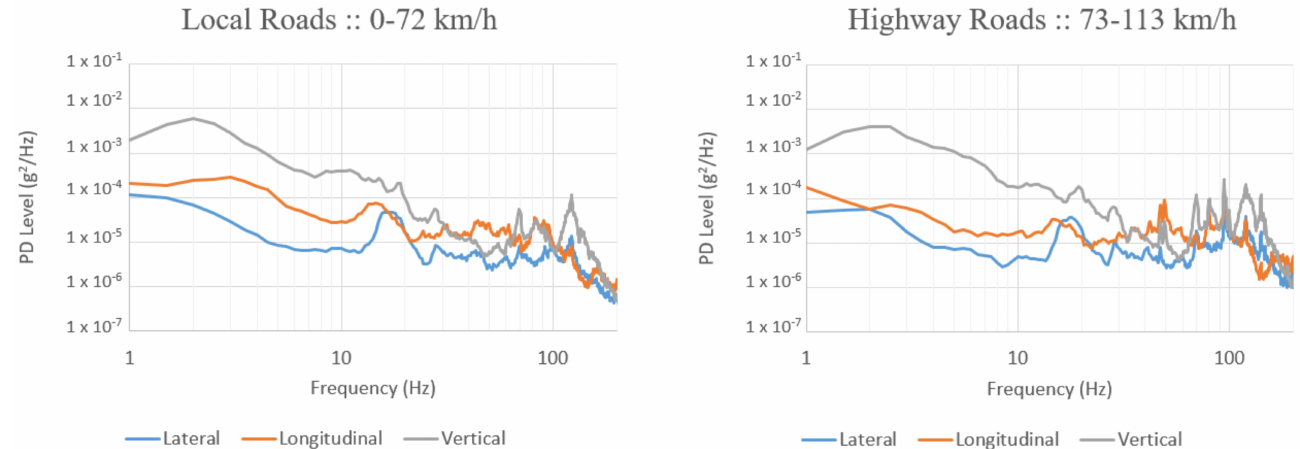
Figure 4. PSD plots for triaxial vibration of the electric Kona compact SUV.